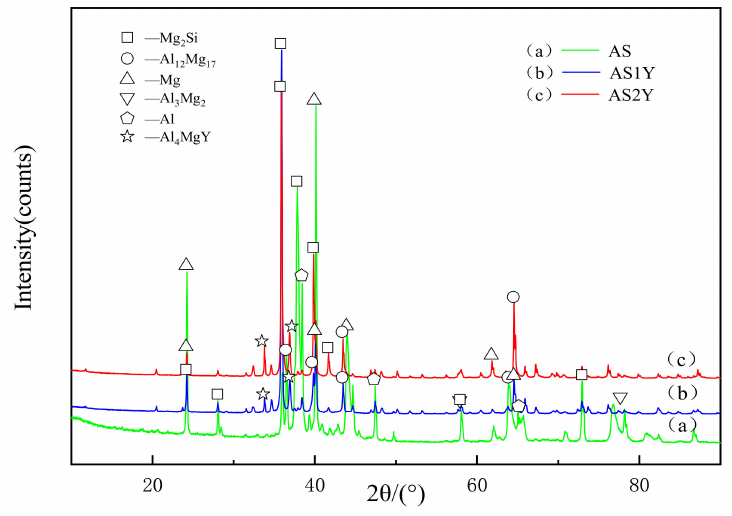
Figure 2. XRD patterns of the laser cladded coatings on AZ91D substrate: ( a ), ( b ) and ( c